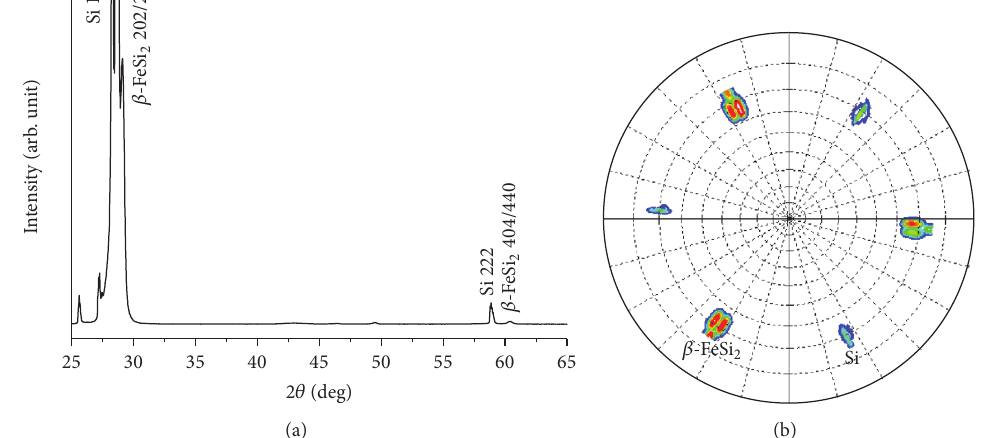
Figure 1: (a) 2 𝜃 - 𝜃 XRD pattern for 𝛽 -FeSi 2 thin films grown on Si(111) substrates and (b) a pole figure pattern for the 𝛽 -440/404 diffraction peak.